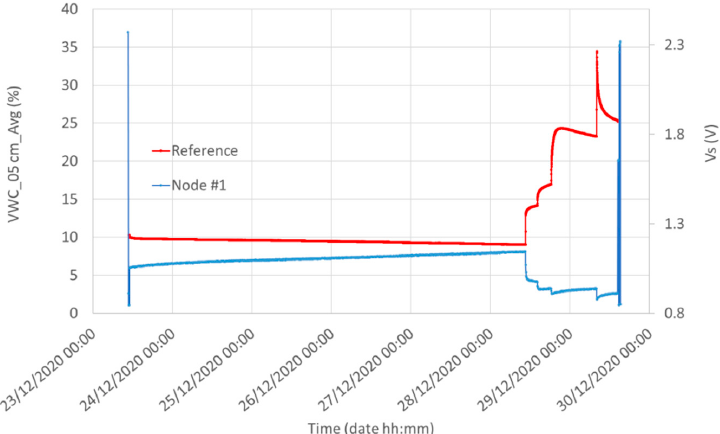
Figure 13. Water content measured by the reference system (red, 5 cm underground) and the Capacitive Soil Moisture Sensor v1.2 (blue) in Silty Loam. Initial and final peaks of the Node #1 plot represent a calibration of the Capacitive Soil Moisture Sensor v1.2 obtained by placing the sensor for 15 min in the air (maximum peak) and 15 min in tap water (minimum peak).